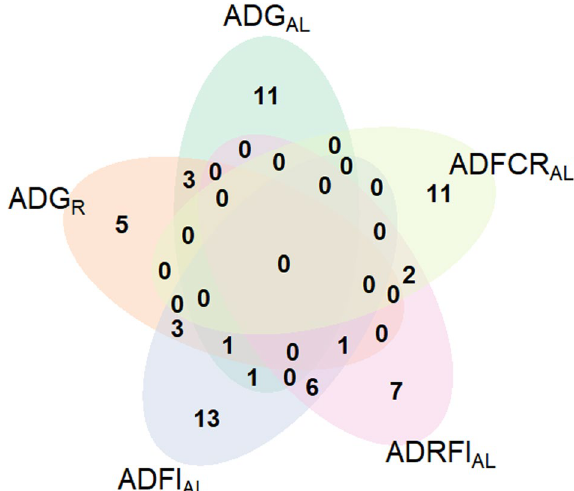
Figure 1. Venn diagram showing the numbers and overlap of most relevant OTUs for the prediction of the 5 traits analyzed. ADG AL , average daily gain in rabbits fed ad libitum; ADG R , average daily gain in rabbits fed under restriction; ADFI AL , average daily feed intake in rabbits fed ad libitum; ADRFI AL , average daily residual feed intake in rabbits fed ad libitum; ADFCR AL , average daily feed conversion ratio in rabbits fed ad